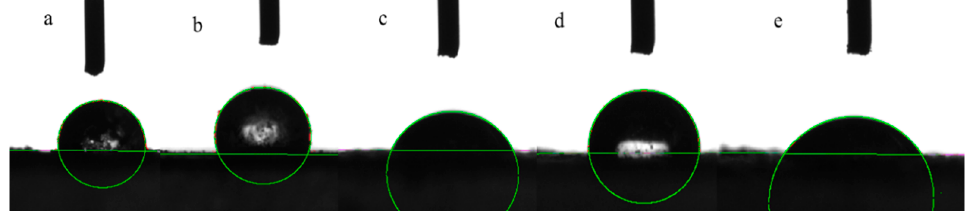
Figure 2. Contact angle of WSG and its conjugates: ( a ) WSG; ( b ) SPI; ( c ) PPI; ( d ) WSG-SPI conjugates; ( e ) WSG-PPI conjugates.